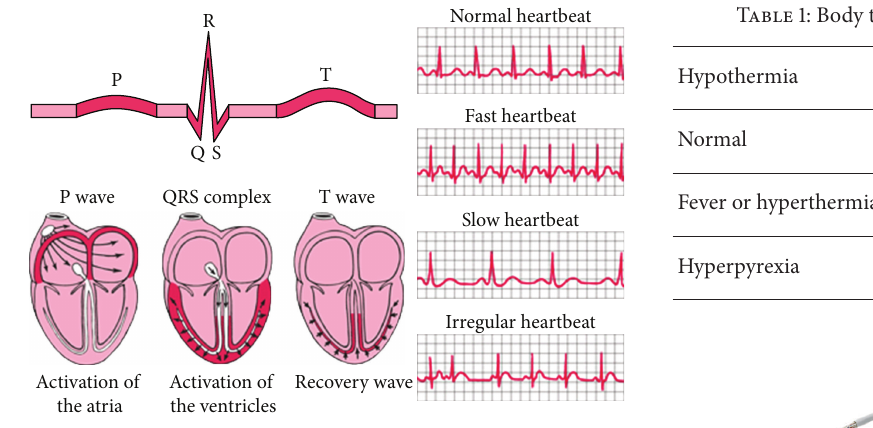
Figure 4: Activity of the heart in mediating an ECG [11].